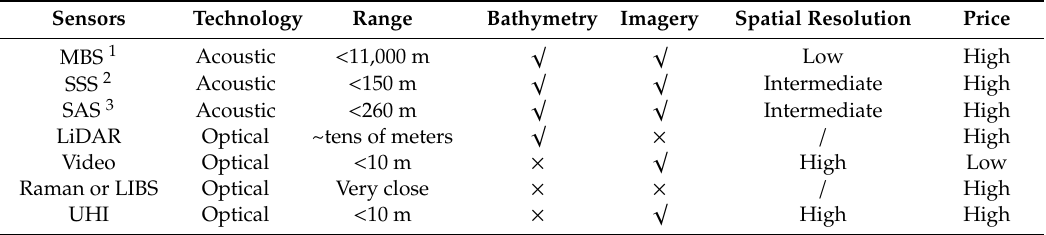
Table 5. Comparison of di ff erent underwater survey